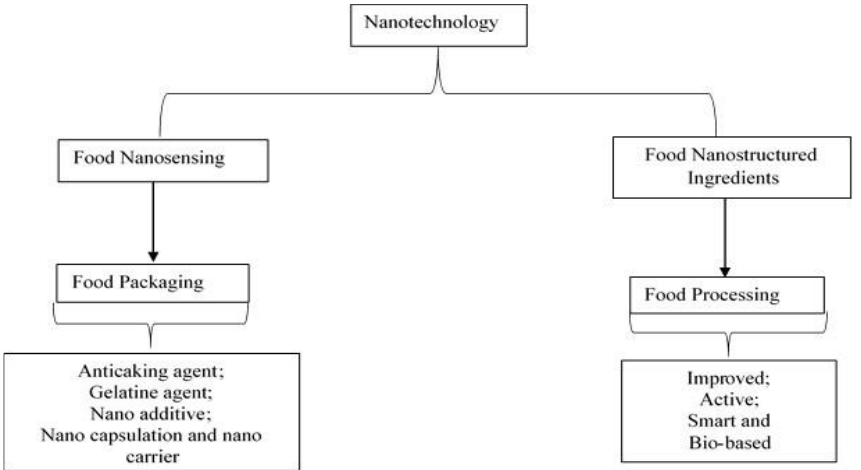
Figure 3. Classification of nanotechnology and its applications (modified from Primozic et al. [11]).